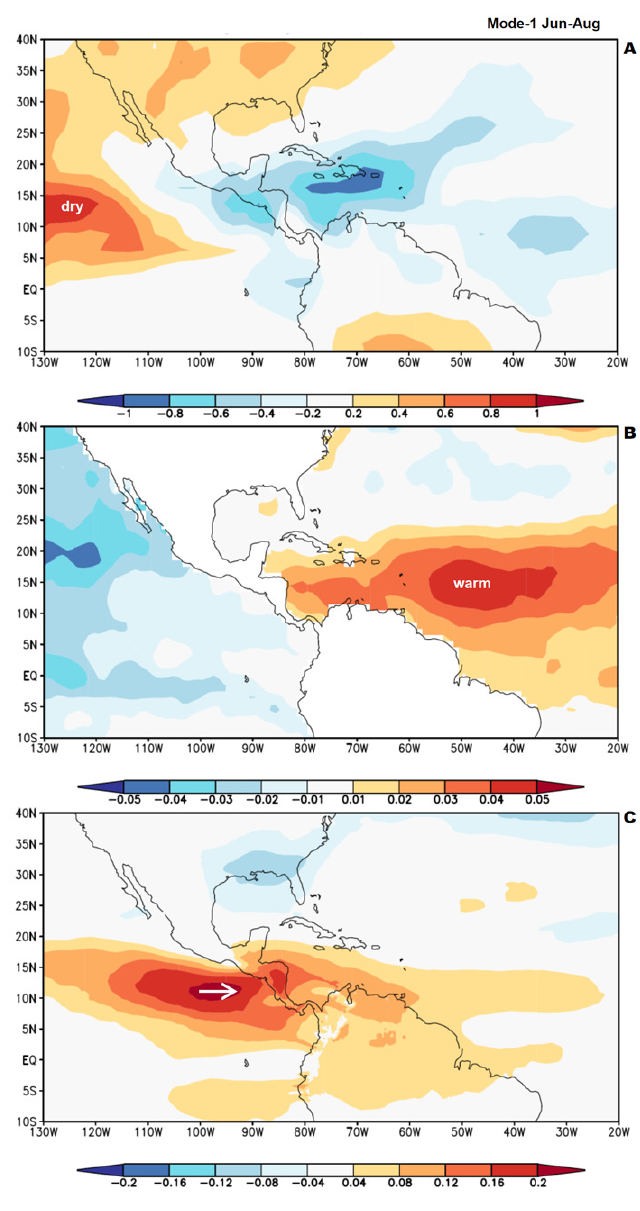
Figure 4. Regression of SVD time score for rain mode-1 Jun-Aug onto fields of: ( a ) net OLR (W/m 2 ), ( b ) SST (°C), and ( c ) 700 hPa zonal wind (m/s).